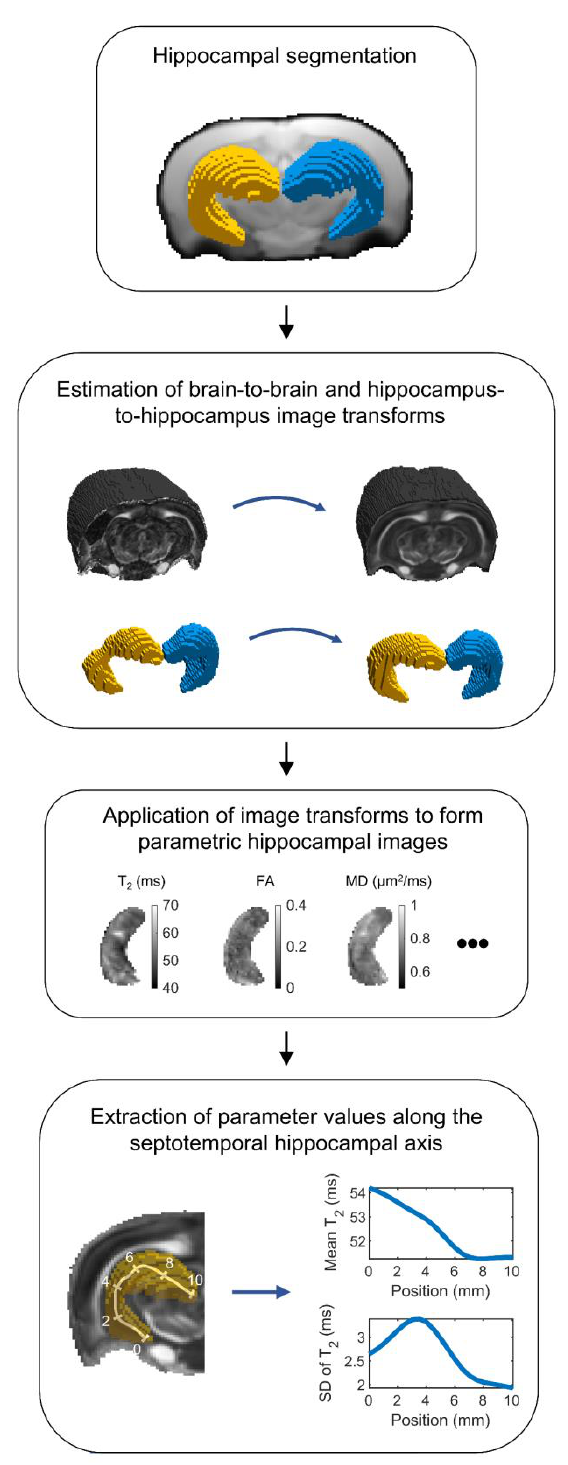
Figure 2. Flowchart of the MRI analysis. First, the ipsilateral and contralateral hippocampi were segmented for each animal using an automated machine learning-based segmentation method. Then, the segmented hippocampal masks were used to estimate image transformations from the hippocampus of each animal to the reference hippocampus. The estimated image transformations were then applied to MRI parameter maps to form parametric hippocampal images in the same reference space. Finally, the hippocampus was skeletonized along its septotemporal axis, and the weighted mean and standard deviation (SD) of each quantitative MRI parameter was calculated along the axis. Abbreviations: FA, fractional anisotropy; MD, mean